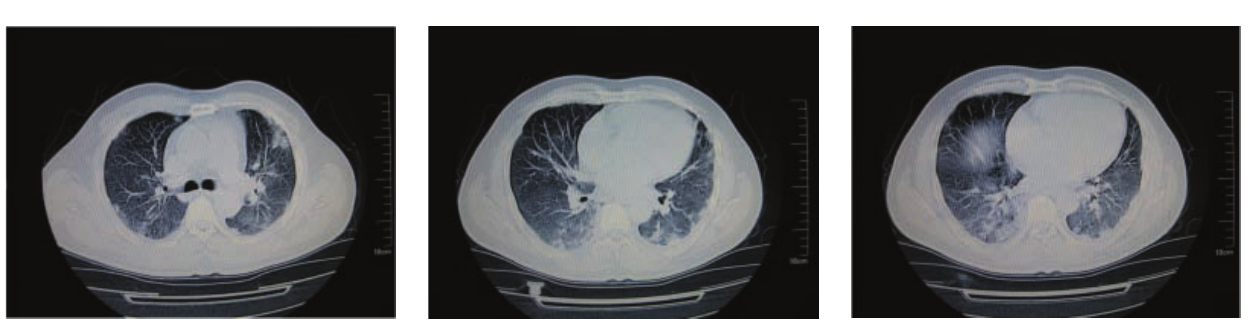
Figure 2. Lung computed tomography. A high density shadow apparently increased in both lungs and diffused to individual leaf of both lungs.